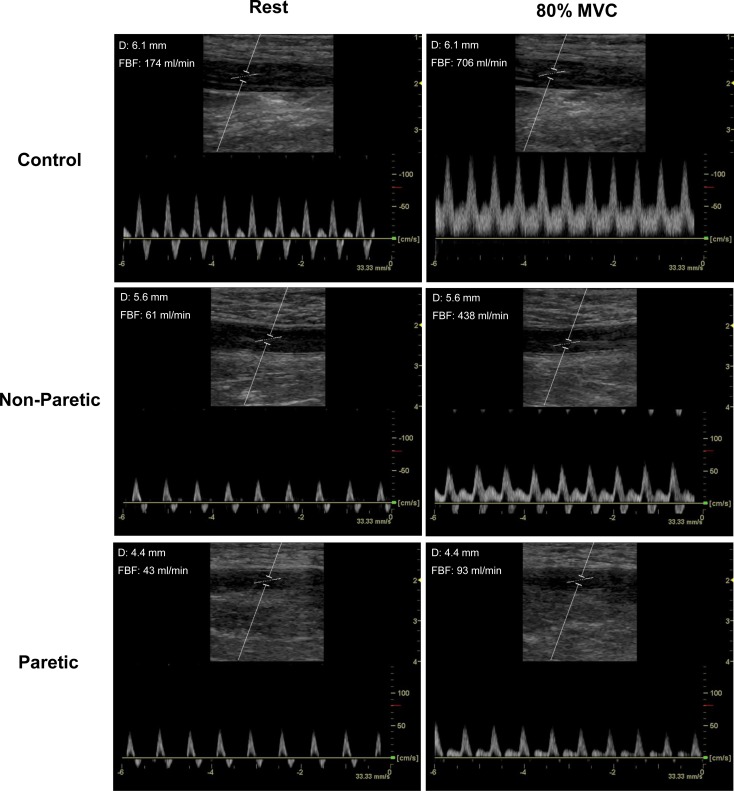
Representative ultrasound images showing blood flow through either the superficial femoral artery of a neurologically intact control subject or the paretic and non-paretic lower limb of a stroke subject at rest or immediately following an 80% MVC.Paretic and non-paretic superficial femoral artery images are from the same subject. D, diameter; FBF, femoral blood flow.